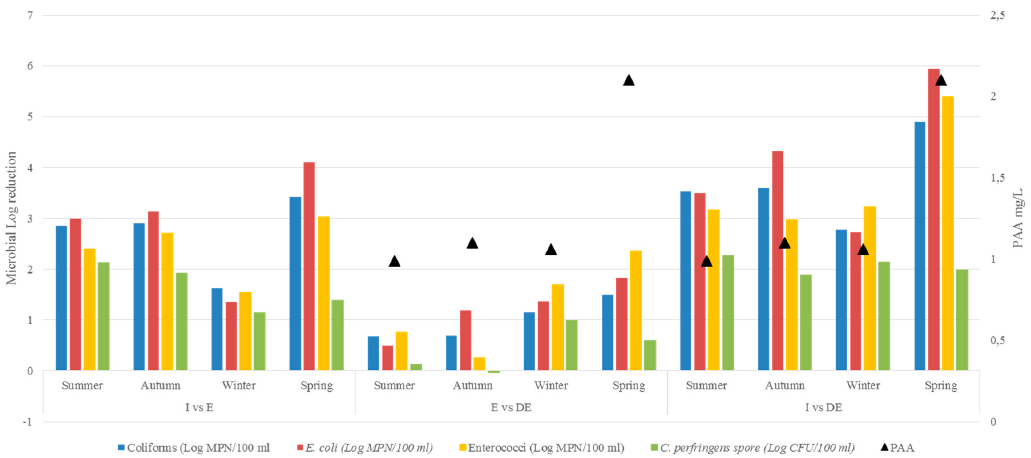
Figure 1. Log reduction of microbial indicators (expressed as log CFU/100 mL or log MPN/100 mL) in the three sampling points (influent = I, effluent = E, disinfected effluent = DE) and PAA doses tested.